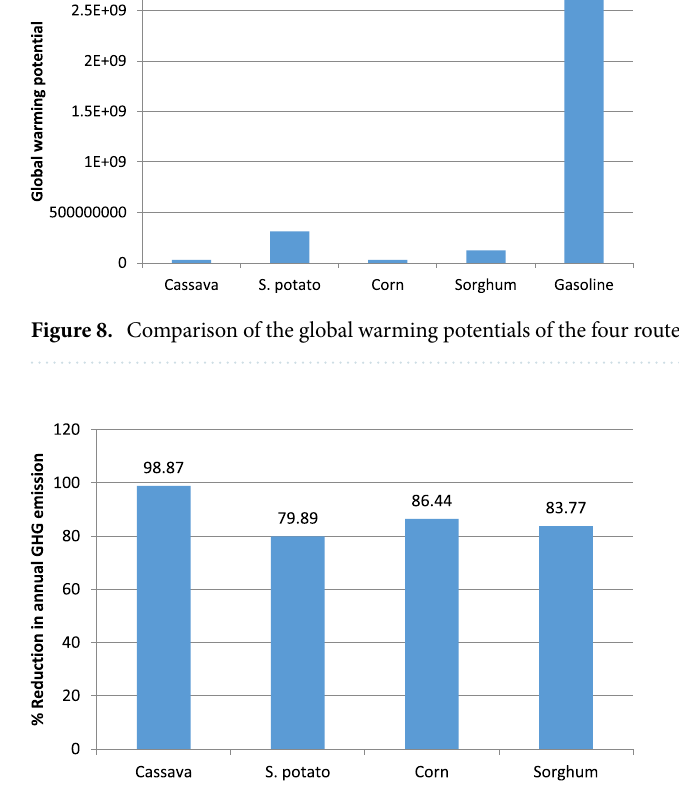
Figure 9. Reduced GHG emission per annum for the four production routes.